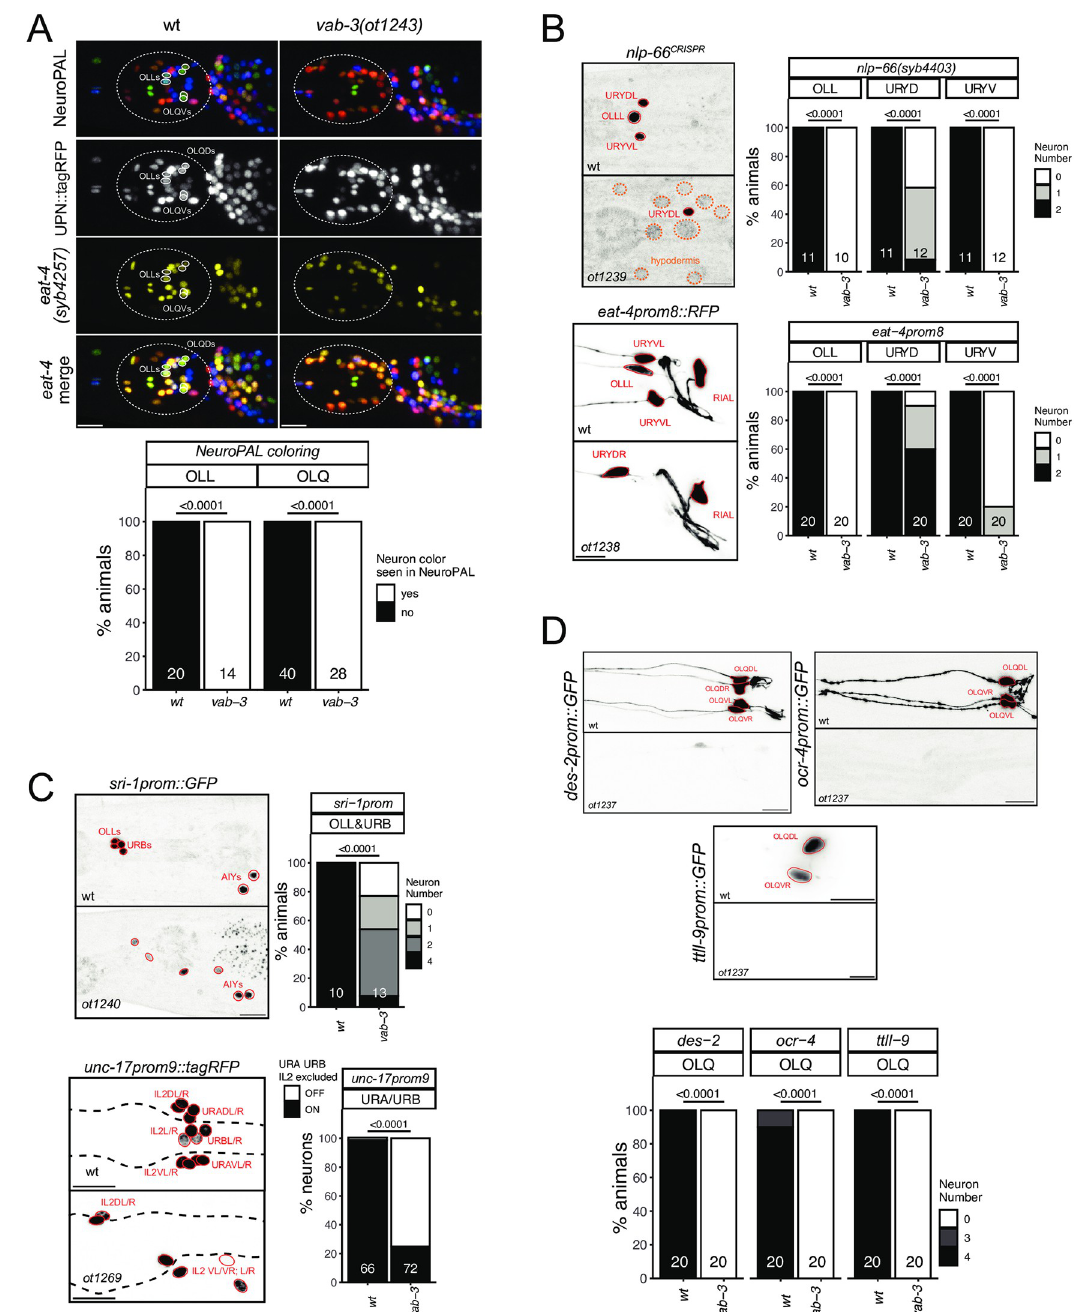
Fig 5. The Eyeless/Pax6 ortholog vab-3 controls the identity of neurons in the anterior ganglion. Fig 5A: In a vab-3(ot1243) mutant allele, many neurons in the anterior ganglion lose their NeuroPAL coloring (from otIs669) and expression of the eat-4 reporter allele (syb4257) . Notably, there are much less blue neurons (URY/URA/URB but URX seem present), and the bright green OLQ and turquoise OLL are never seen. Representative images of wild type and mutant worms are shown with 10 μ m scale bars. Graphs compare expression in wild type and mutant worms with the number of neurons (for n = 10 WT worms / 7 vab-3 mutant ) examined listed at the bottom of the bar. P-values were calculated by Fisher’s exact test. Similar results were observed with a larger deletion allele, ot1269 (S7 Fig). Fig 5B: In vab-3 mutant worms ( ot1239 , ot1238 , all carrying the same lesion, introduced into respective reporter background; S7 Fig), the OLL and URYmarkers nlp-66(syb4403) , eat-4prom8 ( otIs521 ) are affected. Markers are more frequently lost in the ventral URY than the dorsal URY. vab-3 mutants also ectopically express nlp-66 in hypodermal cells. Representative images of wild type and mutant worms are shown with 10 μ m scale bars. Graphs compare expression in wild type